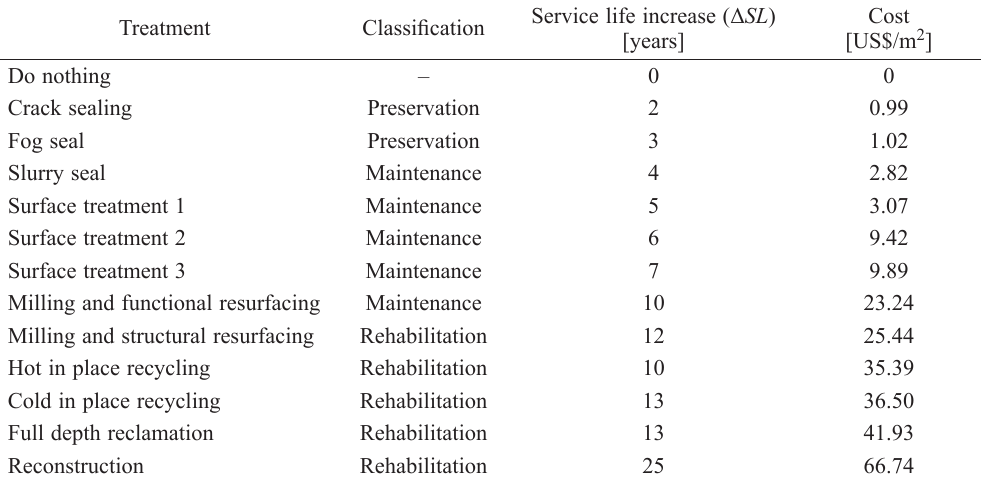
Table 3. Treatment alternatives considered for asphalt